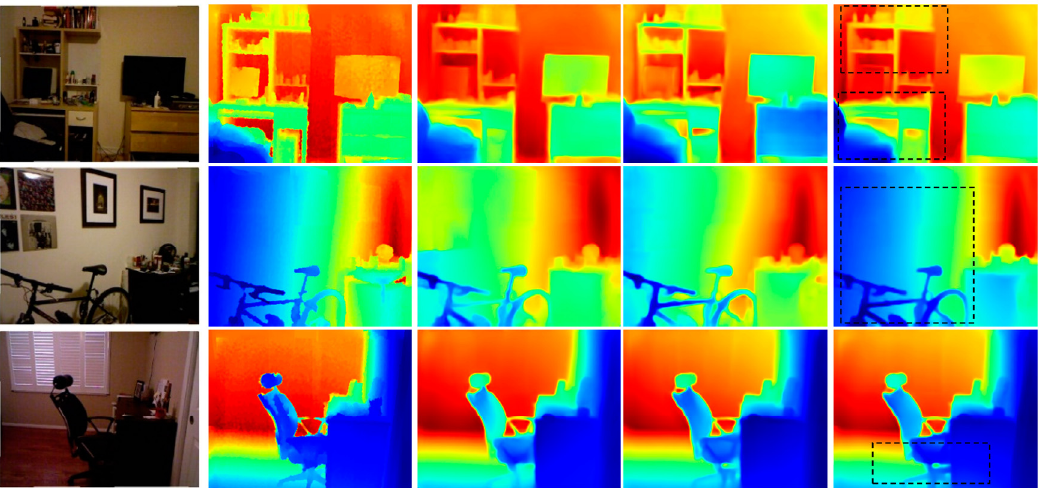
Figure 9. Feature distillation methods on NYU-Depth-V2. Columns from left to right: original RGB images, ground truth depth maps, Hui et al. [43], Liu et al. [44], and proposed approach. Regions in black boxes highlight the better-predicted results. Color indicates depth; red is far, and blue is close. Table 3. Feature distillation performance on NYU-Depth-V2.